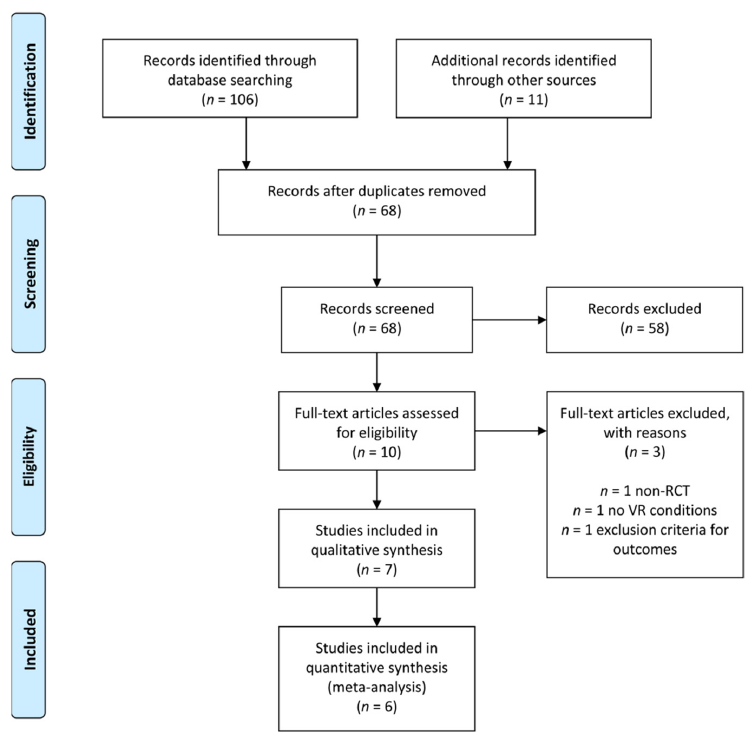
Figure 1. Flow diagram of the studies.